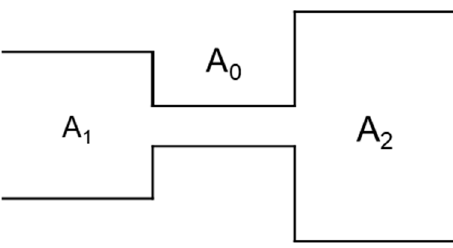
Figure 2. Choke model geometry. 𝐴 (cid:2868) , 𝐴 (cid:2869) , and 𝐴 (cid:2870) are flow areas.